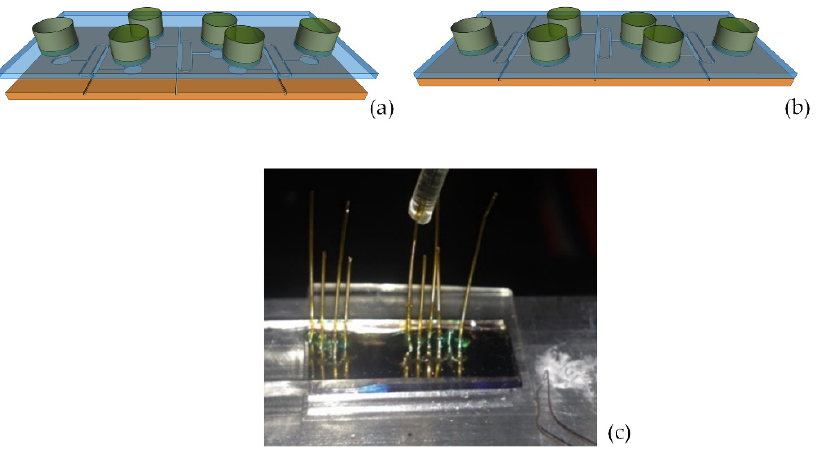
Figure 10. ( a ) Exploded view drawing of the chip. ( b ) Sketch and ( c ) photograph of the final assembled chip.